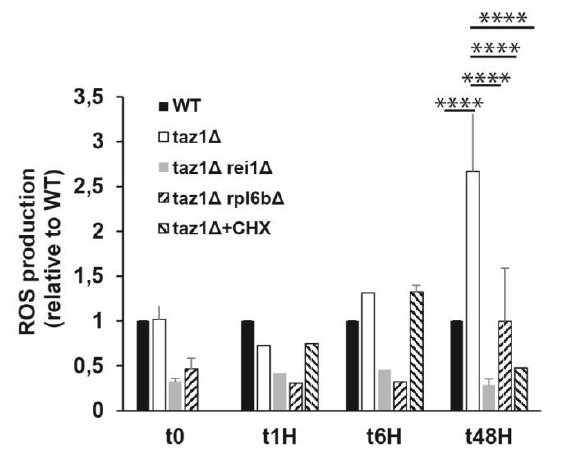
FIGURE 5: Partially decreasing cytosolic translation in taz1 Δ yeast preserves a normal production of ROS. The cells were grown in CSM containing 0.5% galactose + 2% ethanol at 36°C for 48 hours. At the indicated times, ROS levels were measured by flow cytometry using dihydroethidium as a probe. The data are expressed in % relative to the WT at T0 (n=3). Statistical analysis was done with Tukey’s test (*P<0.05; **P<0.01; ***P<0.001; ****P<0.0001). The data for WT and taz1 Δ strains were reported previously